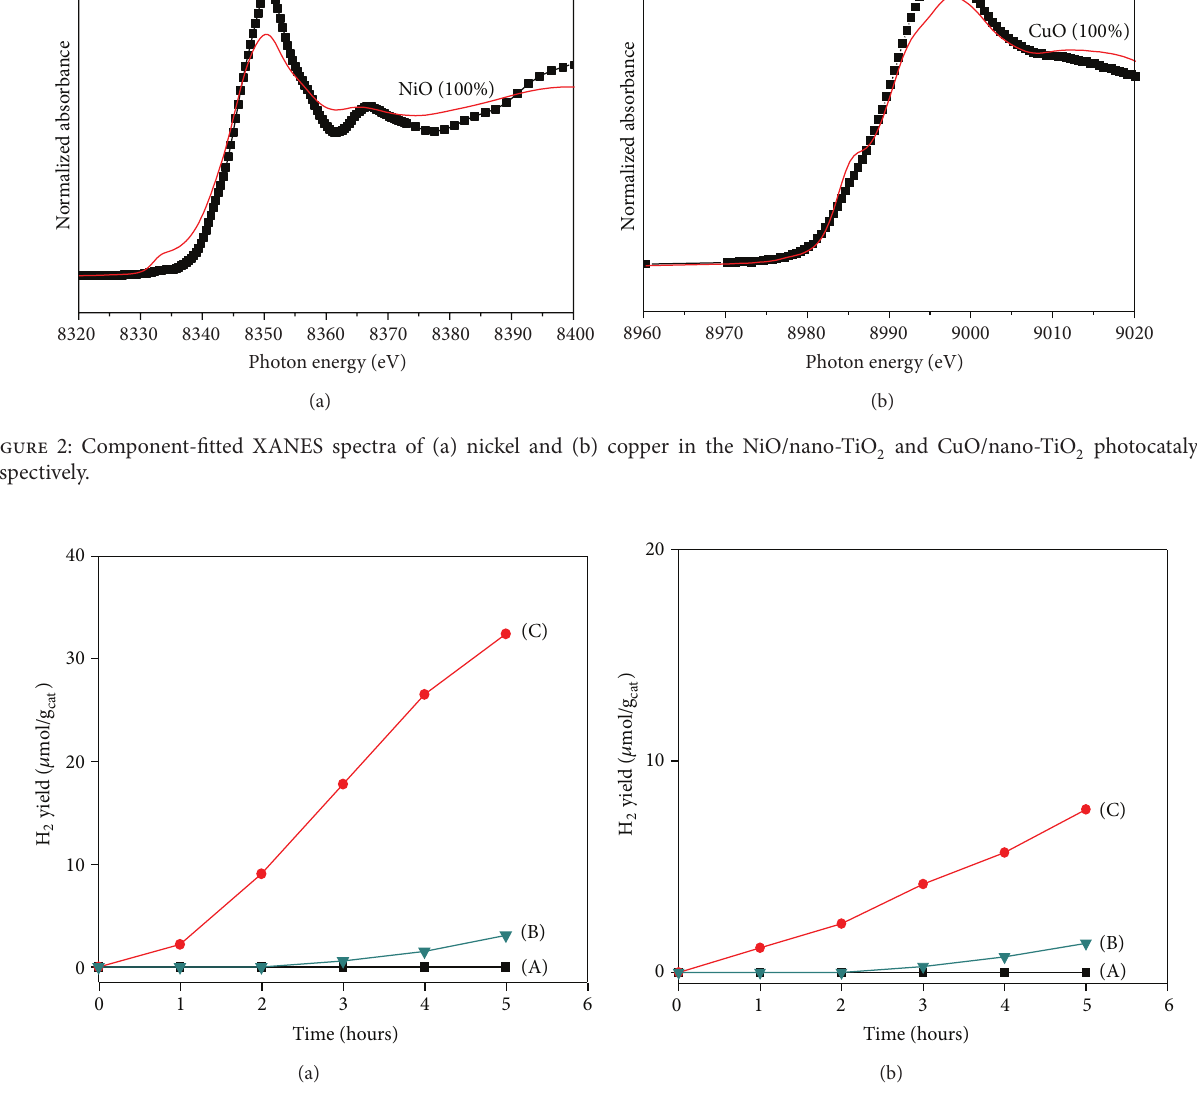
Figure 3: Photocatalytic splitting of (a) water and (b) seawater with 50mM oxalic acid sacrificial reagent affected by (A) nano-TiO 2 , (B) NiO/nano-TiO 2 , and (C) CuO/nano-TiO 2